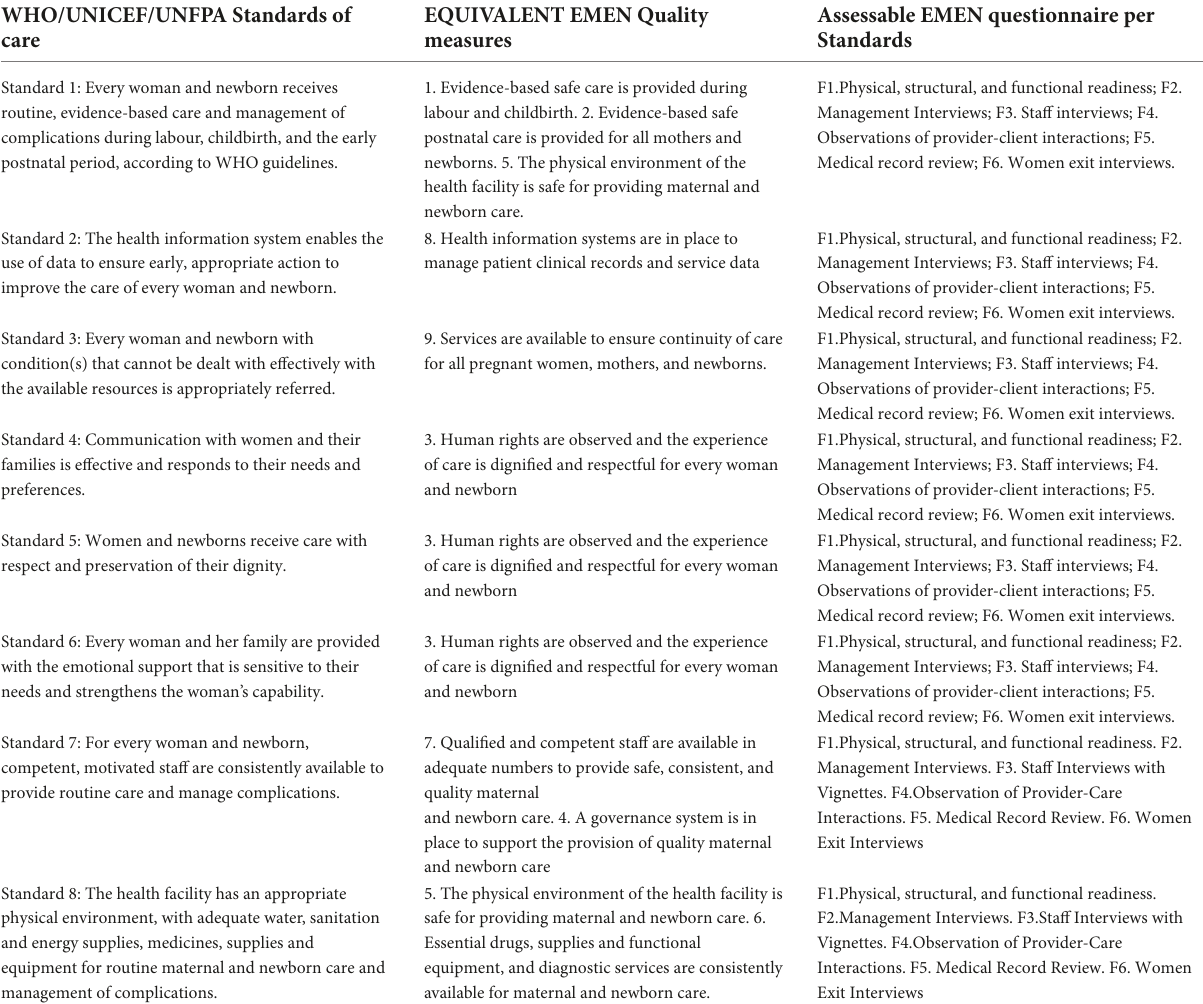
TABLE 1 WHO/UNICEF/UNFPA quality standards and EMEN quality measures and tool. Eight WHO/UNICEF/UNFPA standards, nine EMEN quality measures, by six EMEN tool. WHO/UNICEF/UNFPA Standards of